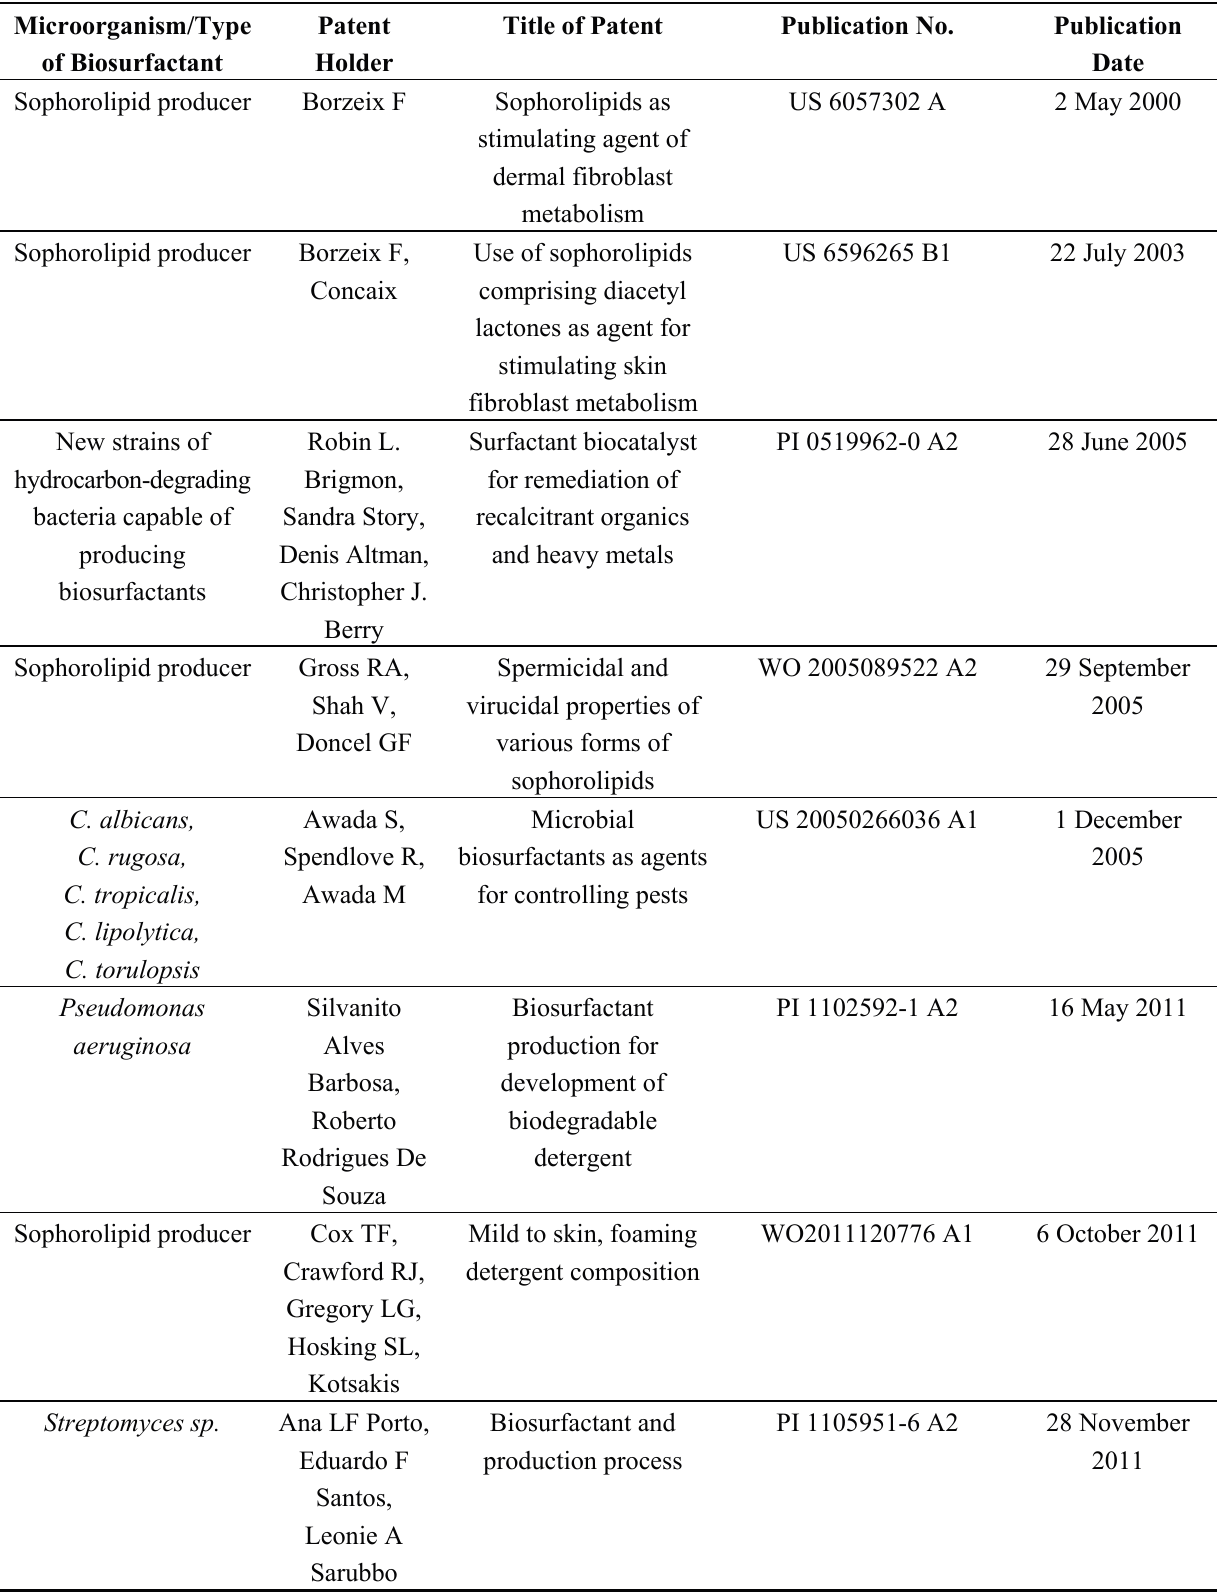
Table 1. Patents on biosurfactants produced by